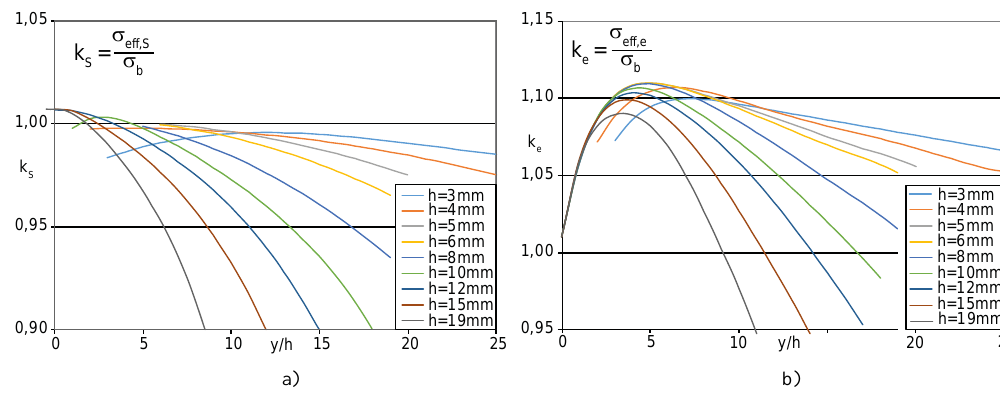
Fig. 2 Correction factors for flat glass for a glass thickness of 3 mm to 19 mm; a) surface factor k S ; b) edge factor k e according to Blank (1994). The representation on the left is not included in EN